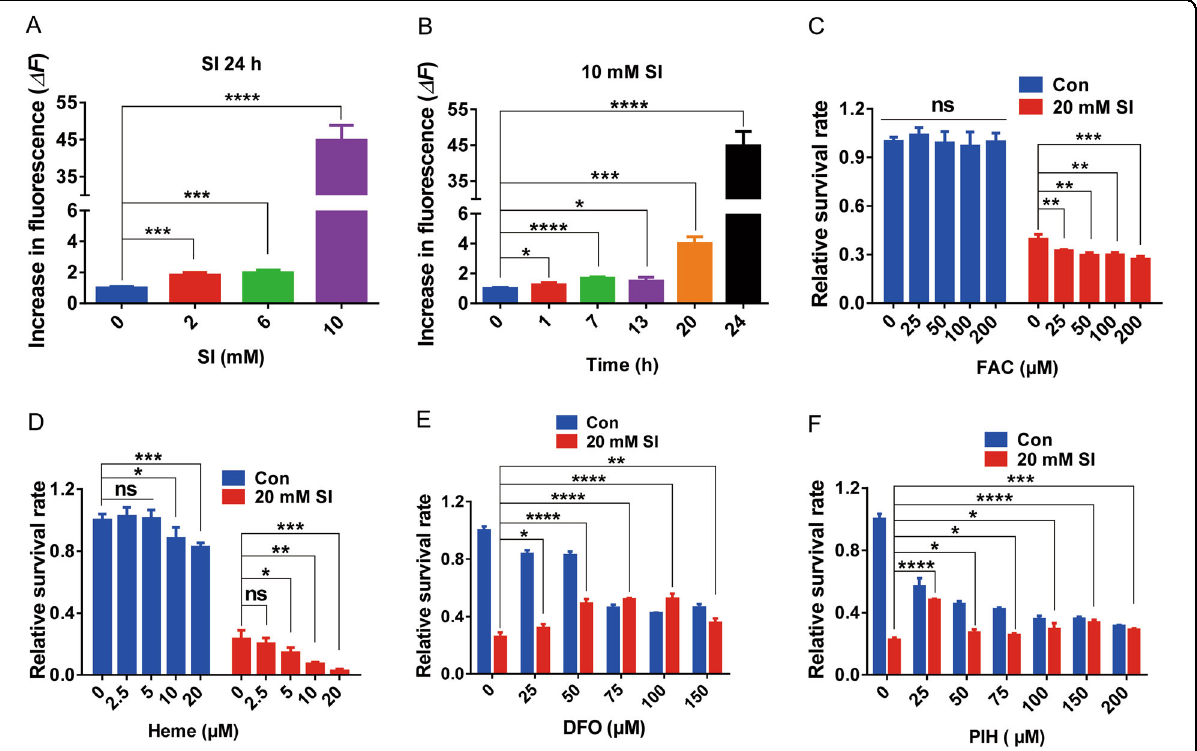
Fig. 3 Death of ARPE-19 cells induced by SI is related to the intracellular labile iron. A , B Alteration of labile iron levels in ARPE-19 cells with NaIO 3 treatment in concentration ( A ) or time ( B ) dependent manner. The labile iron levels were assessed as the increase in fl uorescence ( Δ F ) 30 min after PIH addition ( n = 4). C Viabilities of ARPE-19 cells treated with indicated concentrations of FAC (ammonium ferric citrate) for 24 h followed by additional 24 h treatment with or without 20 mM NaIO 3 ( n = 5). D Viabilities of ARPE-19 cells treated with indicated concentrations of Heme or vehicle alone (DMSO) for 24 h followed by additional 24 h treatment with or without 20 mM NaIO 3 ( n = 5). E The protective role of DFO for SI- induced cell death. ARPE-19 cells were pretreated with DFO at indicated concentrations or solvent alone (PBS) for 24 h prior to co-treatment with 20 mM